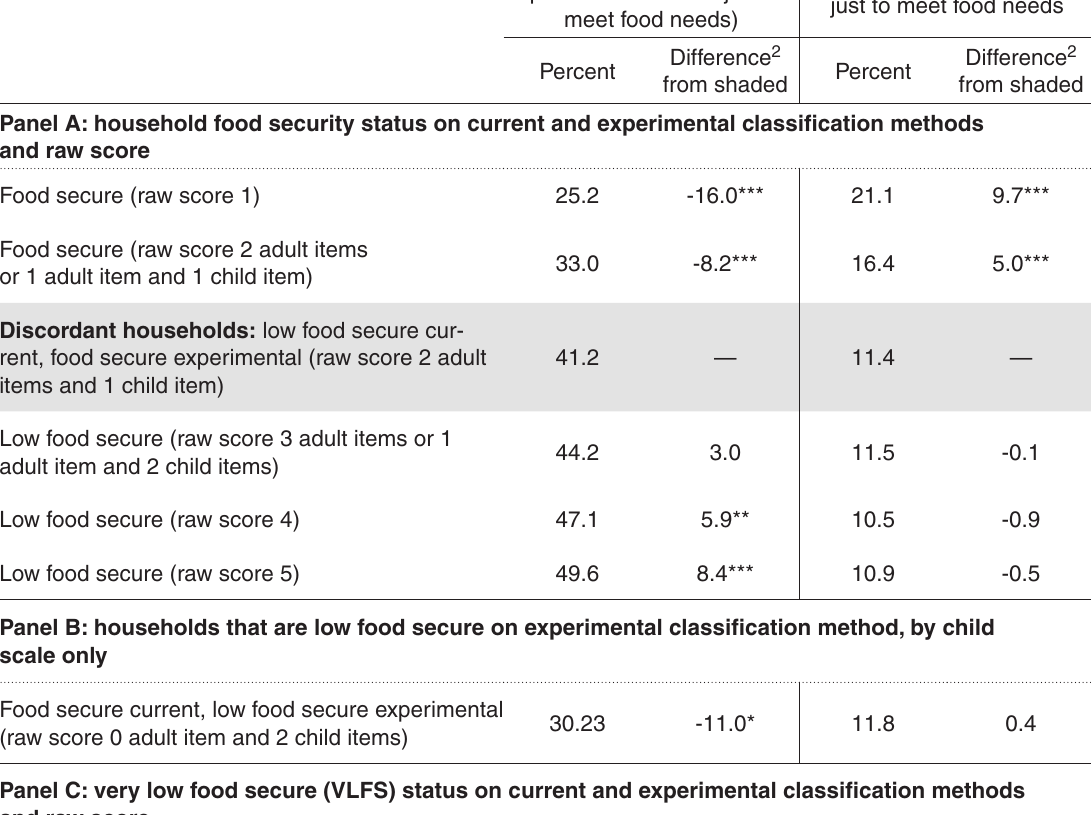
Unmet food needs (need to Could spend less on food spend more on food just to just to meet food needs meet food needs) Difference 2 Difference 2 Percent Percent from shaded from shaded